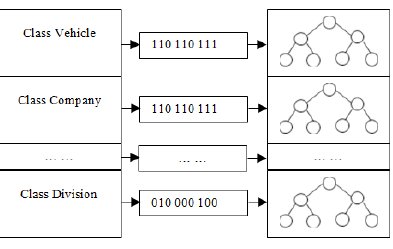
Figure 7 . SD-Tree construction